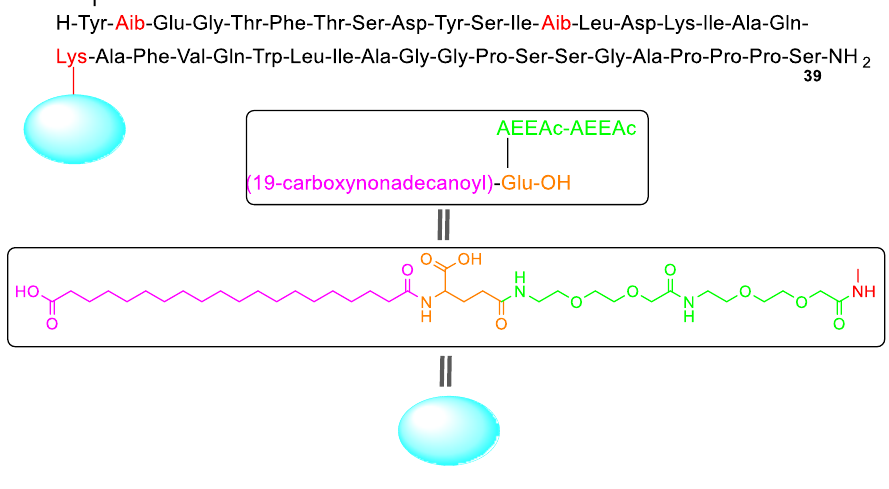
Figure 3. Structure of tirzepatide.